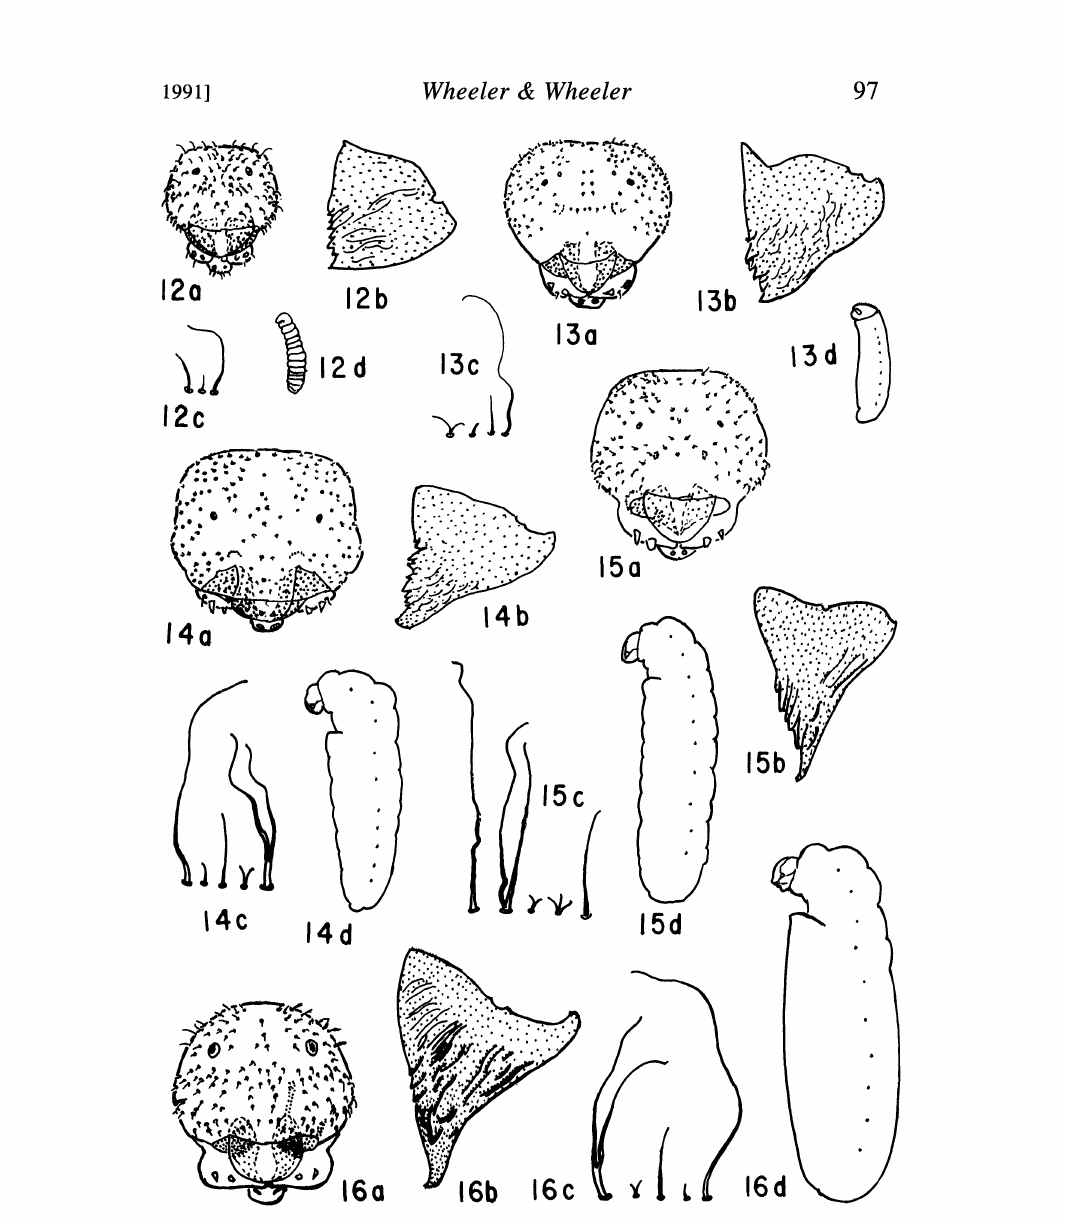
Figures 12-16. Colobopsis abdita. 12, First instar; 13, second instar; 14, third instar; 15, fourth instar; 16, fifth instar (=mature larva), a, Head in anterior view, 56; b, left mandible in anterior view, 200; c, body hairs, 100; d, larva in side view (hairs omitted),